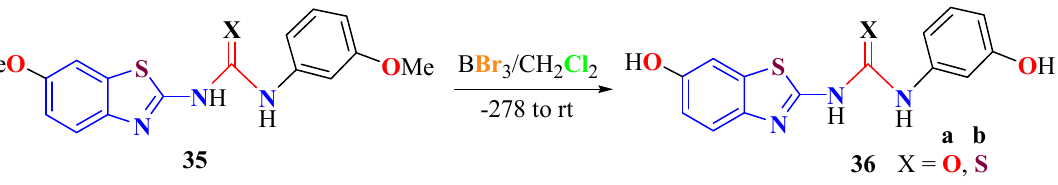
Figure 7. The resultant 1-(5,6- or 1-(5,7-dihalogenide-BT-2-yl)-3-ethylurea in DMF/H 2 O was treated with pyridine-3-boronic acid and potassium phosphate (K 3 PO 4 ) to generate the corresponding 6-fluoro-5-substituted-ethylUBT 37 , 5,7-disubstituted-ethylUBTs com- pounds 38 – 41 , and 4-fluoro-5,7-disubstituted-ethylUBT as 42 in approximately 65% yield. Ethyl-UBTs 37 – 42 were tested against Gram-positive and Gram-negative pathogens. The minimum inhibitory concentration (MIC 90 ) values for 37 were found to be: S . aureus = 0.06 µ g/mL, S . pneumoniae = 0.015 µ g/mL, S . epidermidis = 0.03 µ g/mL, and E . faecalis = 0.25 µ